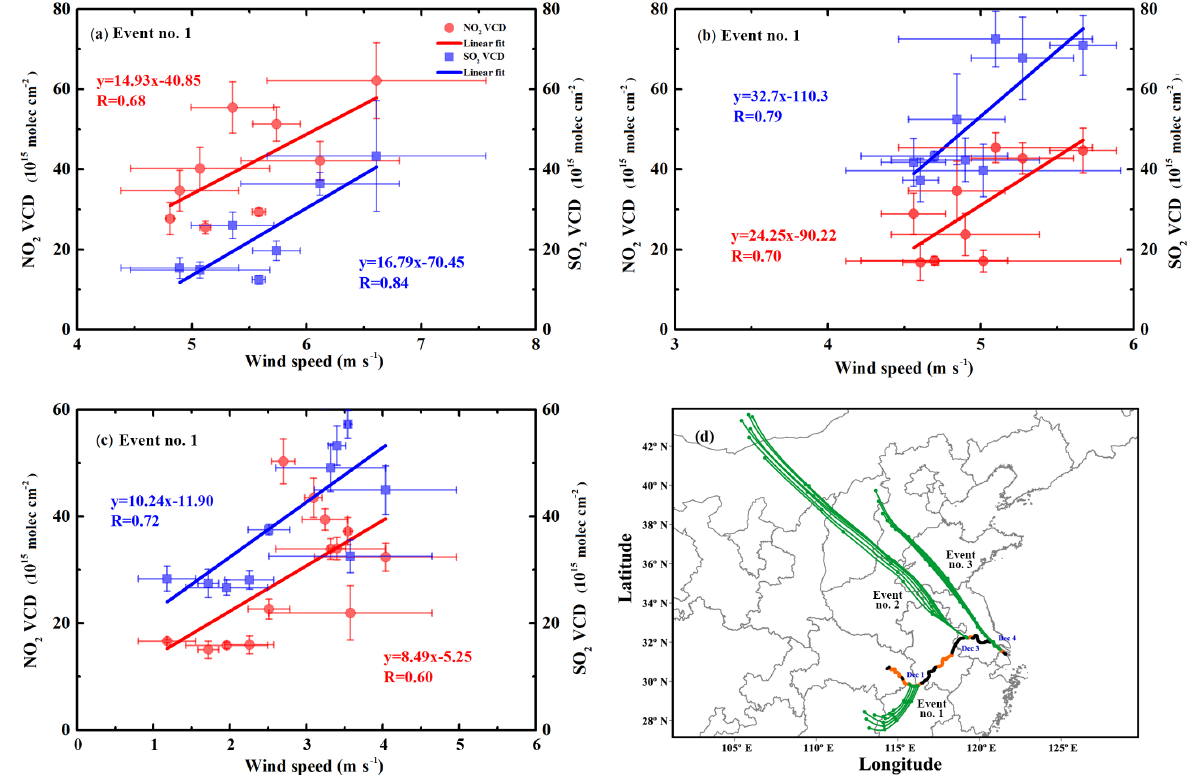
Figure 6. (a–c) Correlation analysis of ship-based MAX-DOAS VCDs (red circles show the NO 2 VCDs and blue squares show the SO 2 VCDs) and wind speed for three high VCDs events. (d) Yangtze River cruise track and 24h backward trajectories calculated by the NOAA HYSPLIT model for three events (green marks indicate starting point: − 6, − 12, − 18 and − 24h, respectively). The data were 30min averages. The error bars show the 1 σ of mobile DOAS VCDs and wind